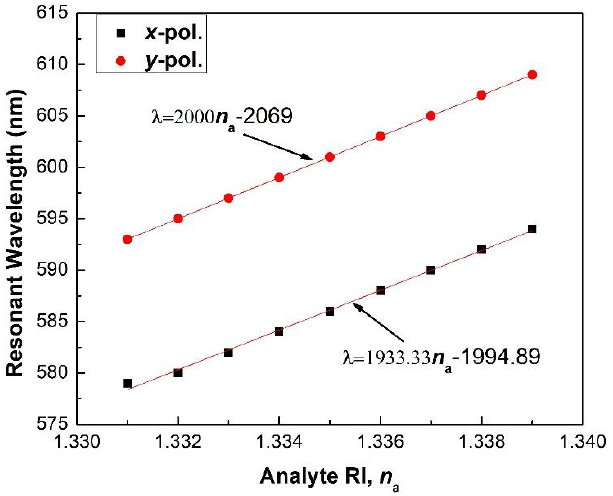
Figure 4. Comparison of the sensitivity for x and y polarization when the analyte refractive index is